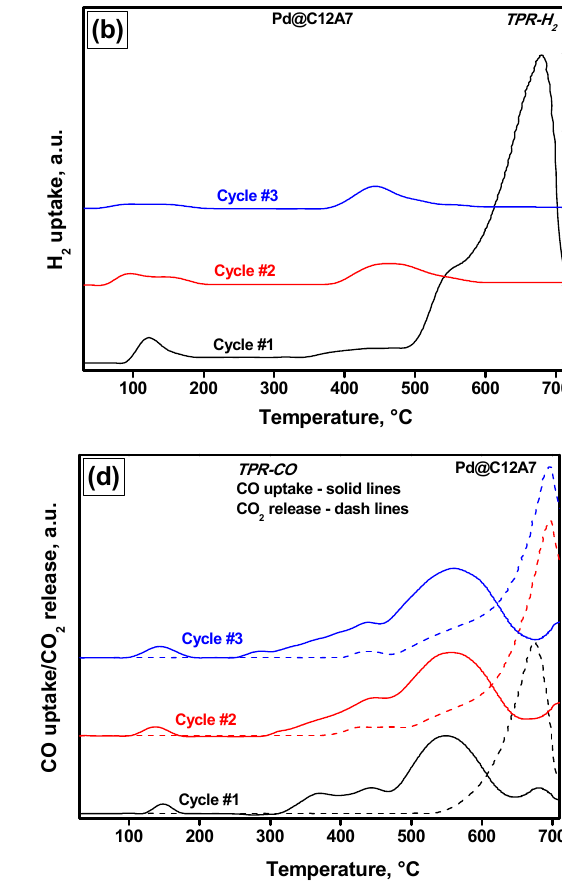
Table 3. Quantitative data for TPR-H 2 and TPR-CO experiments.